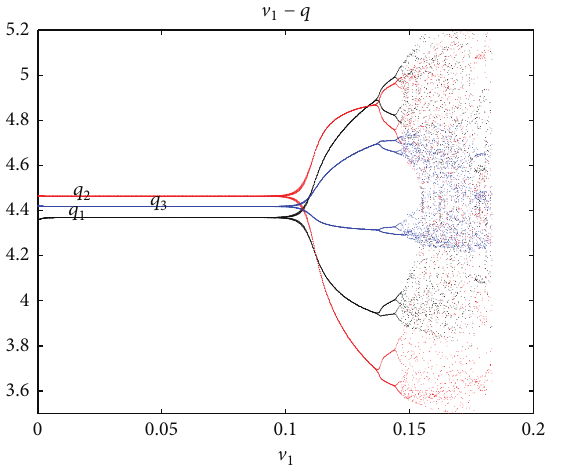
Figure 5: Lyapunov index with the change of V 1 .